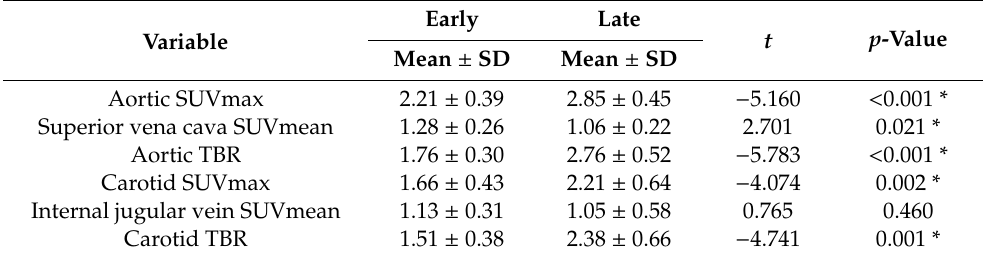
Table 2. Comparison between early and late [ 18 F]FDG PET / CT-derived